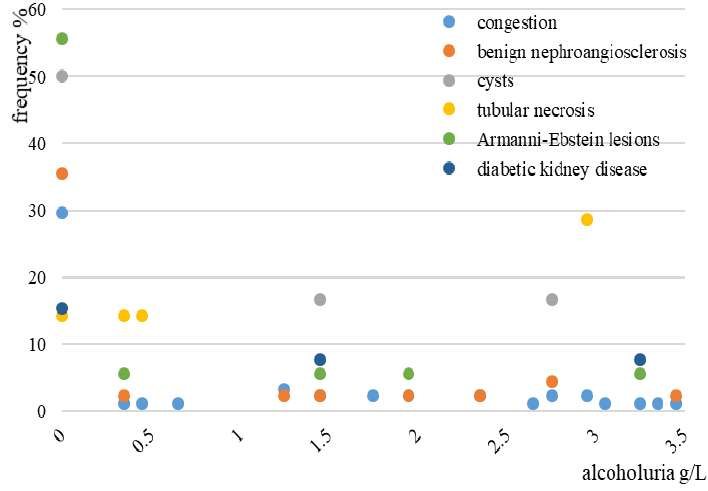
Figure 7. Frequency of cases according to alcoholuria and kidney microscopy findings in the study group.